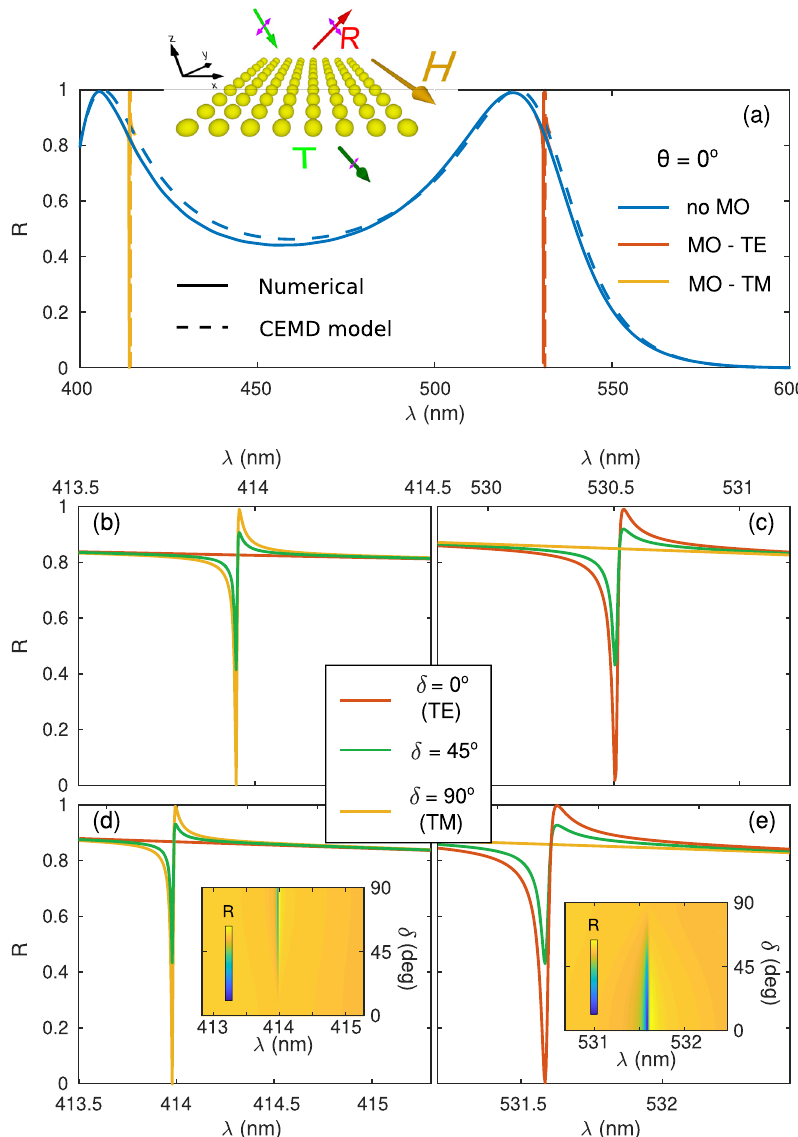
Figure 1: (a) Reflectance spectra R ( 𝜔 ) at normal angle of incidence 𝜃 = 0 ◦ from an infinite square array of lossless semicon- ductor ( n = 3 . 5) nanospheres (lattice period a = 300 nm, sphere diameter D = 150 nm), as a function of the wavelength 𝜆 , calculated through FDTD simulations (solid curves) and our CEMD formulation (dashed curves), with and without MO activity, for linear polariza- tions: 𝛿 = 0 ◦ (TE), 𝛿 = 45 ◦ ,and 𝛿 = 90 ◦ (TM). MO activity is accounted for: in FDTD